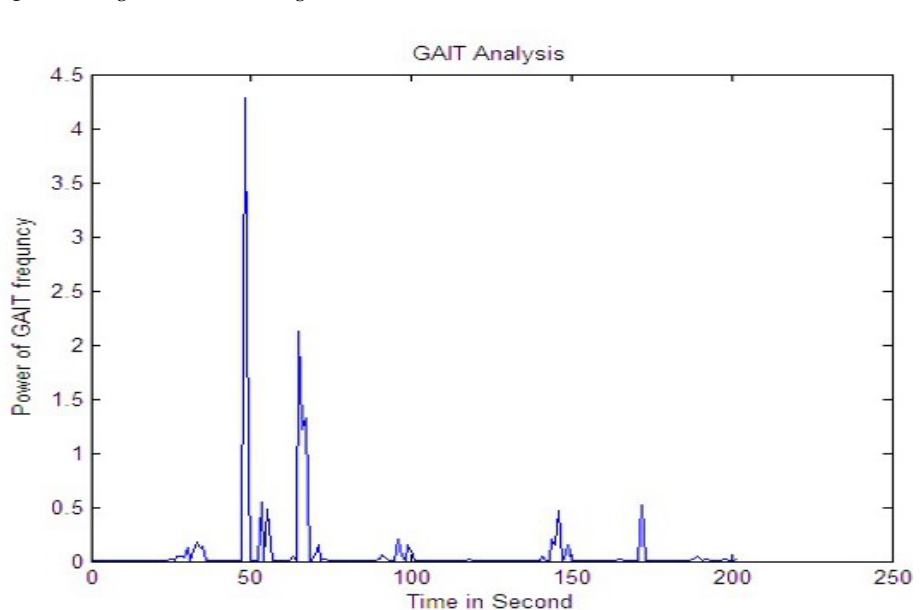
Figure 14. Signal while